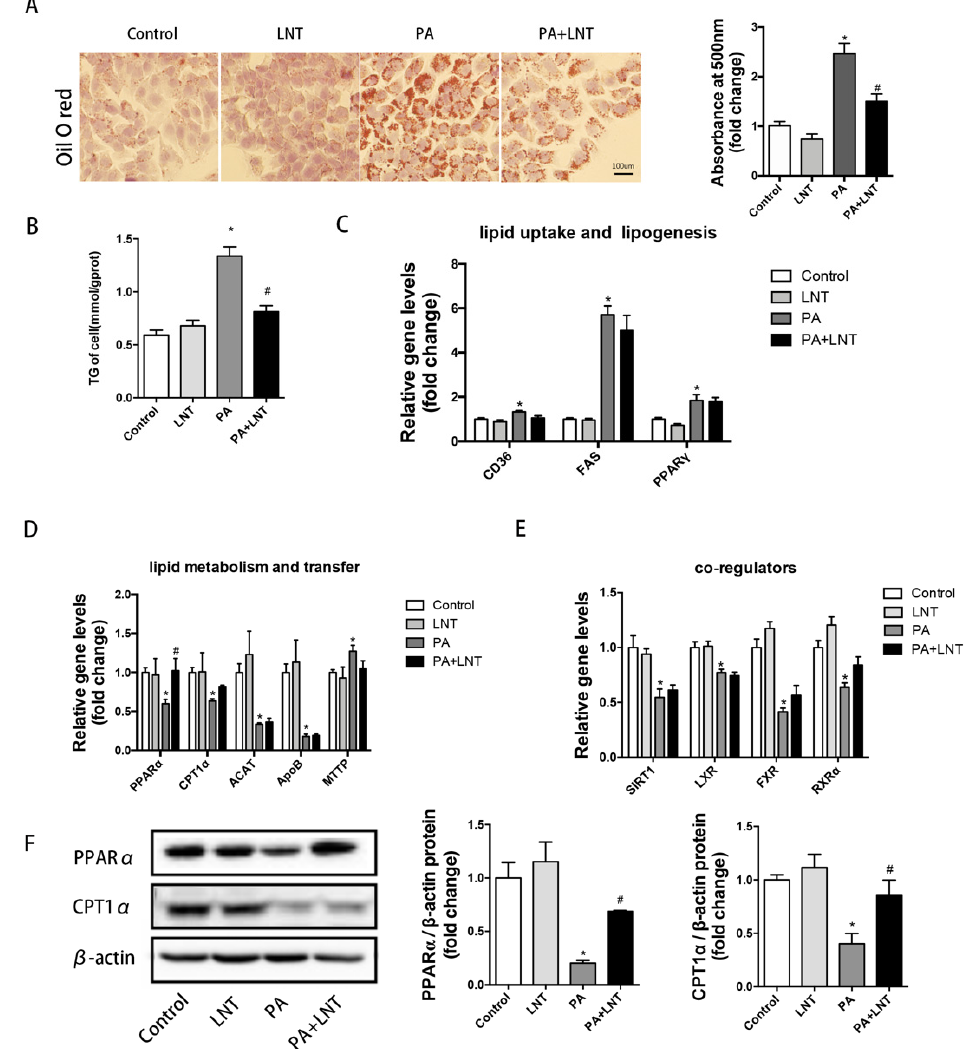
Figure 3. LNT alleviated lipid accumulation in PA-induced AML12 cells. ( A , B ) Oil red O staining and TG content in AML-12 cells. ( C – E ) mRNA levels of lipid uptake-, lipogenesis-, metabolism-, and transfer-related genes in AML-12 cells. ( F ) Representative Western blots and quantification of PPAR α and CPT1 α in AML-12 cells. Data are presented as the mean ± SEM ( n = 3 per group). * p < 0.05 compared with the Control group. # p < 0.05 compared with the PA group.